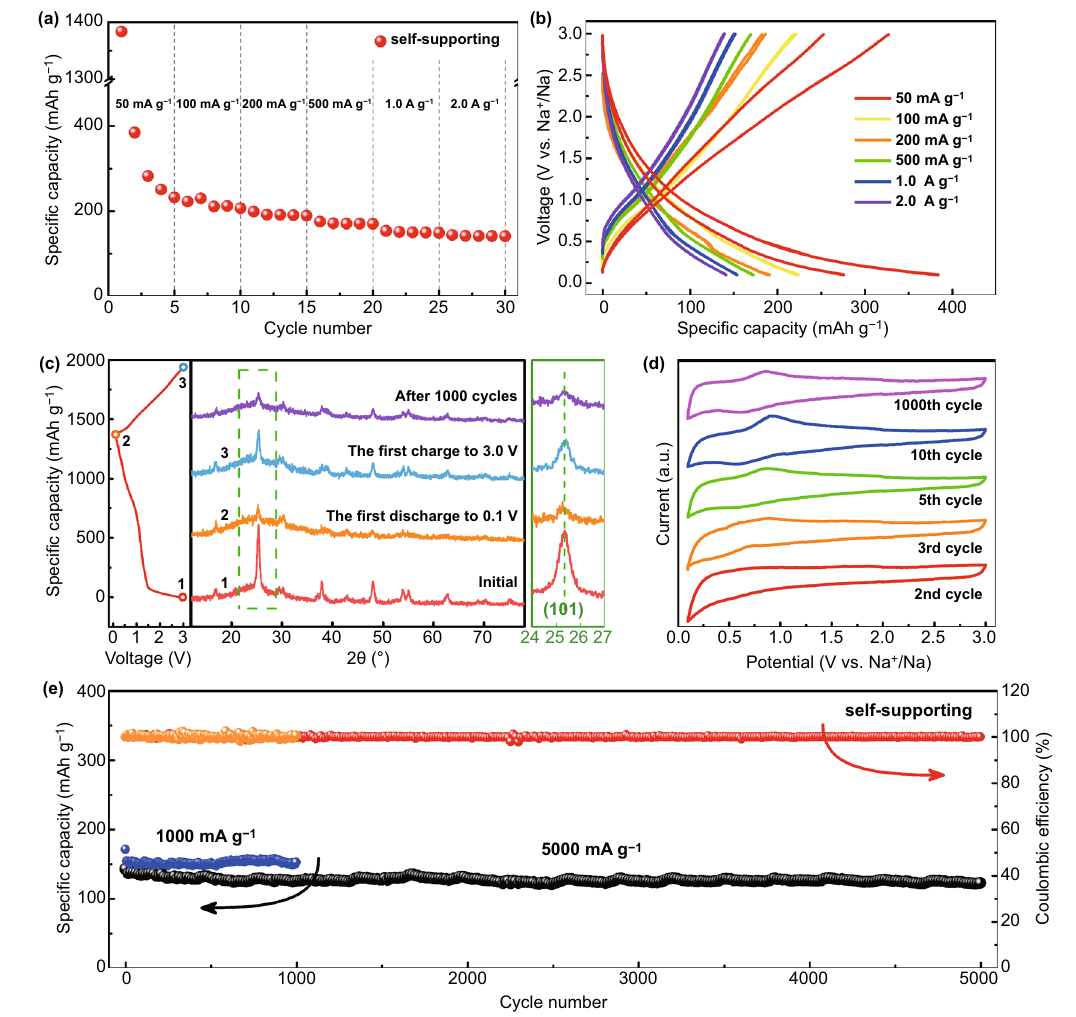
Fig. 4 Electrochemical characterization of the self‑supporting M‑TiO 2 @rGO electrode in half cells. a Rate performance; b charge–discharge curves between 0.1 and 3.0 V from 50 mA g −1 to 2.0 A g −1 ; c XRD curves at different charging and discharging stages; d CV curves after galva‑ nostatic charging‑discharging tests with different cycles; and e 1000 and 5000 cycles cycling performance at 1.0 and 5.0 A g